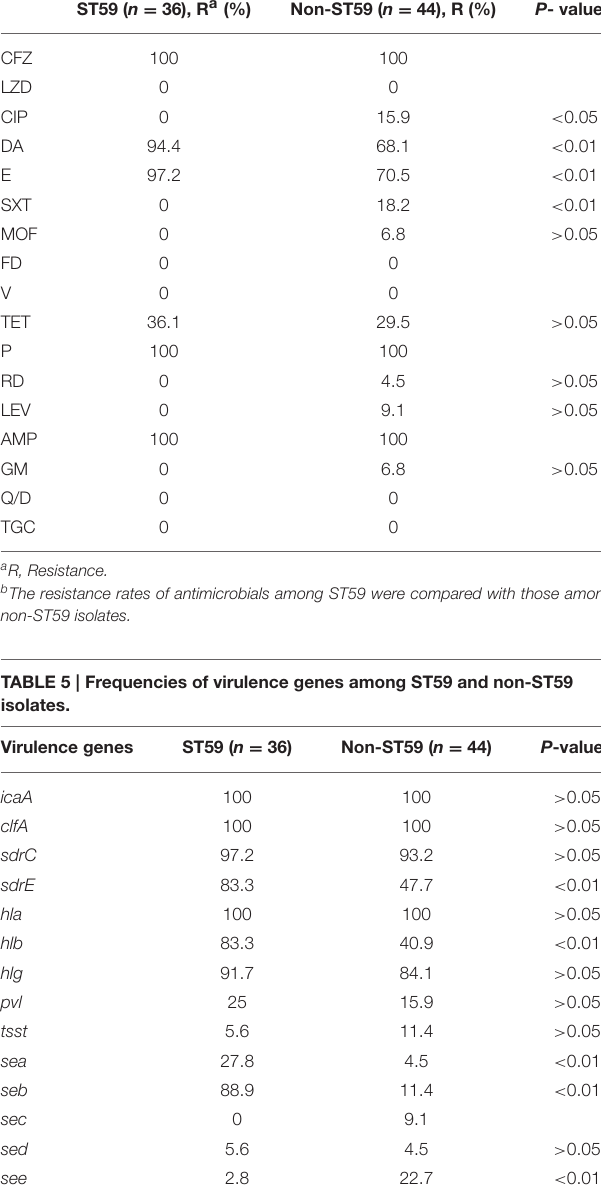
TABLE 4 | Antimicrobial susceptibility profiles of ST59 and non-ST59 isolates. ST59 ( n = 36), R a (%) Non-ST59 ( n = 44), R (%)